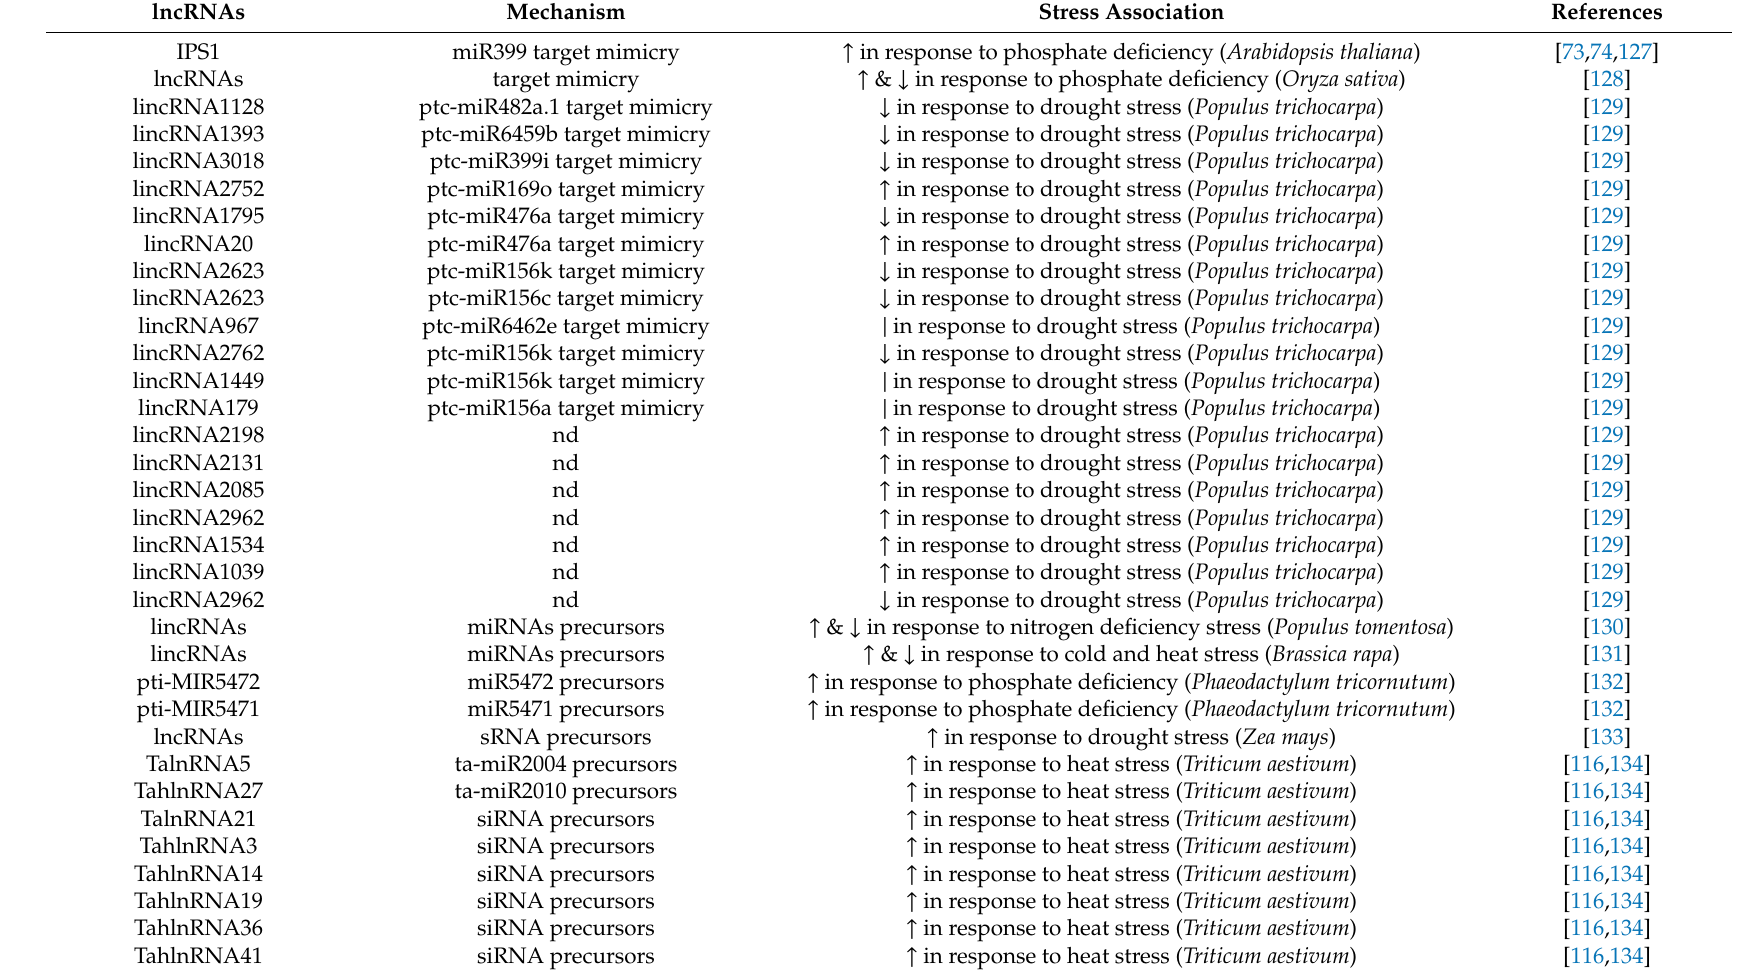
Table 2. Examples of lncRNAs associated with abiotic stress response in